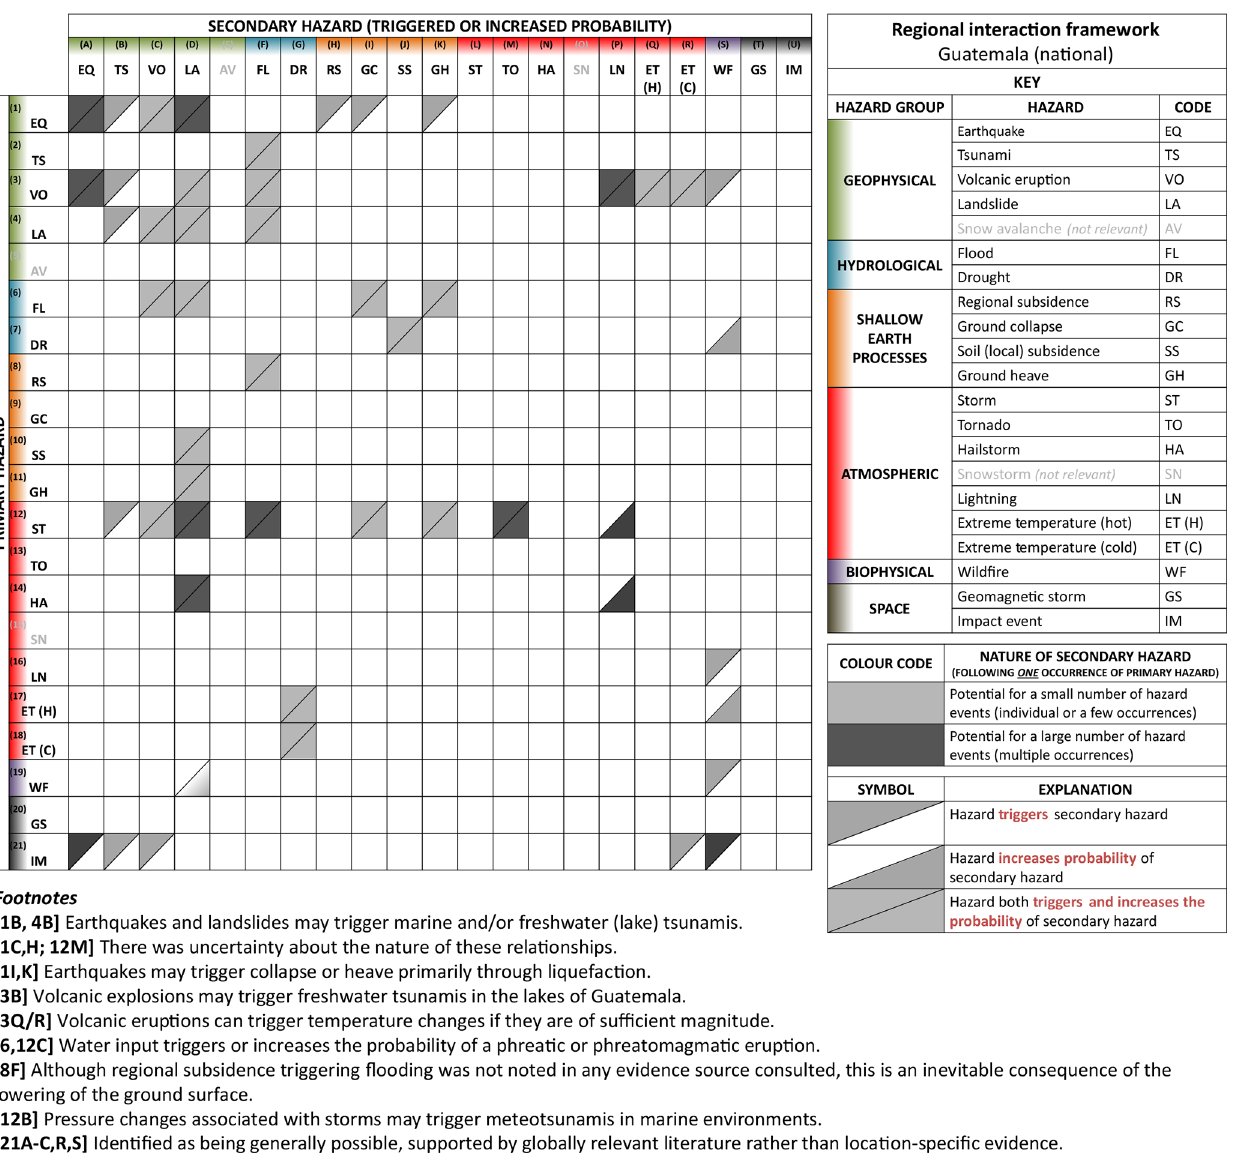
Figure 3. National interaction framework for Guatemala. A 21 × 21 matrix with 21 primary natural hazards on the vertical axis and the same 21 natural hazards presented as secondary hazards on the horizontal axis. Hazard type abbreviations (e.g. SN) shaded grey are determined as not being relevant in Guatemala. Interactions (shaded triangles in cells) include primary hazards triggering a secondary hazard (upper left triangle shaded in cell) and primary hazards increasing the probability of a secondary hazard occurring (lower right triangle shaded in cell). This matrix is populated using different evidence types, as outlined in Sect. 2. Visualisation structure based on Gill and Malamud (2014). See also an additional matrix in Fig. S5, showing the number of evidence types used for each hazard interaction pairing when populating Fig.